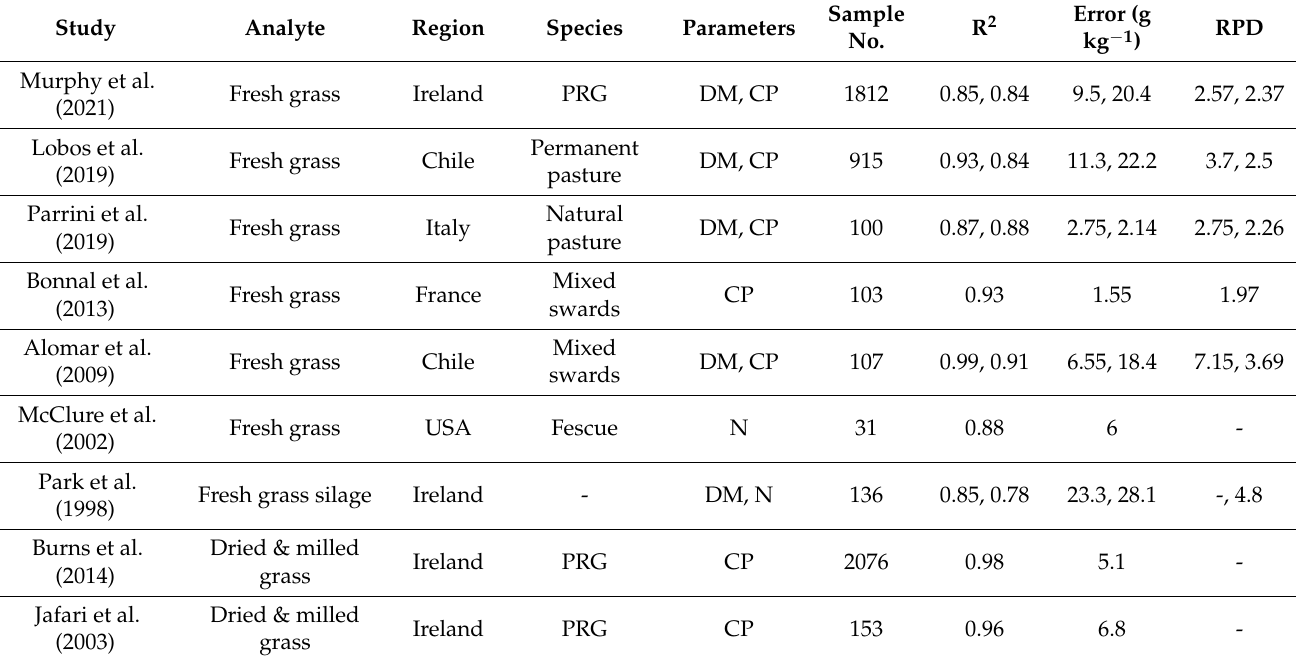
Table 2. Summary of NIRS grass quality studies and calibration statistics relevant to temperate grassland presented in Murphy et al.